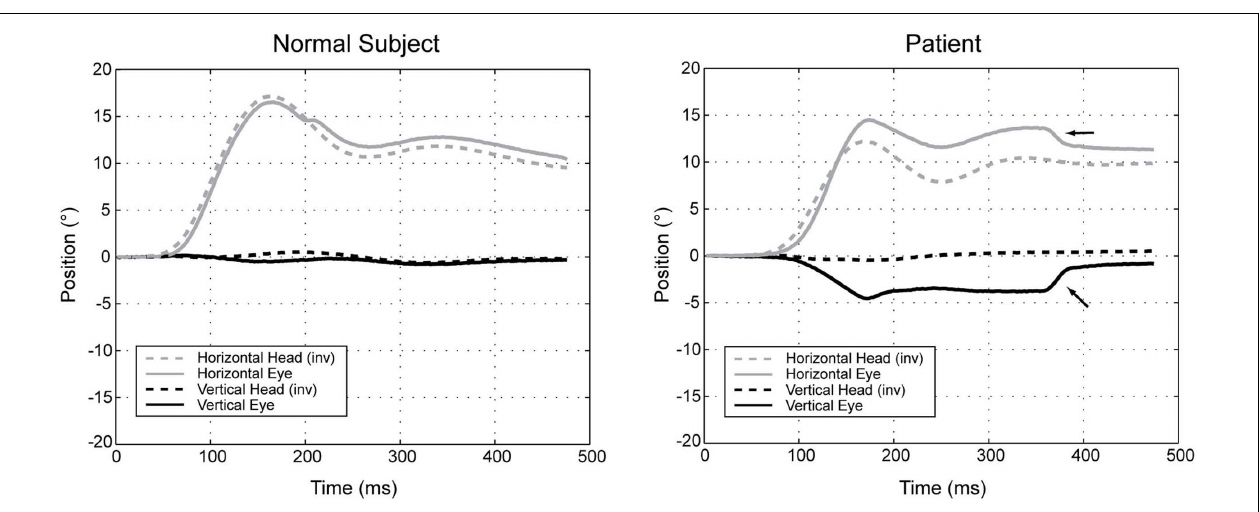
essentially no downward head movement.The arrows indicate horizontal and vertical components of a saccade that partially corrects the gaze position error. Right-hand-rule conventions are used: positive positions are leftward and downward, except for head positions, which are inverted to facilitate comparison (reprinted fromWalker and Zee (2005a), with permission from the American Physiologic Society).